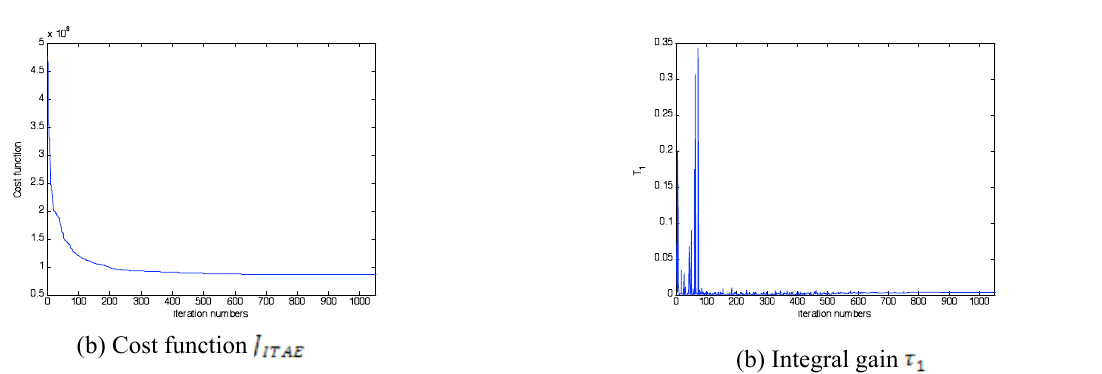
Fig. 11. Controller parameters for criterion